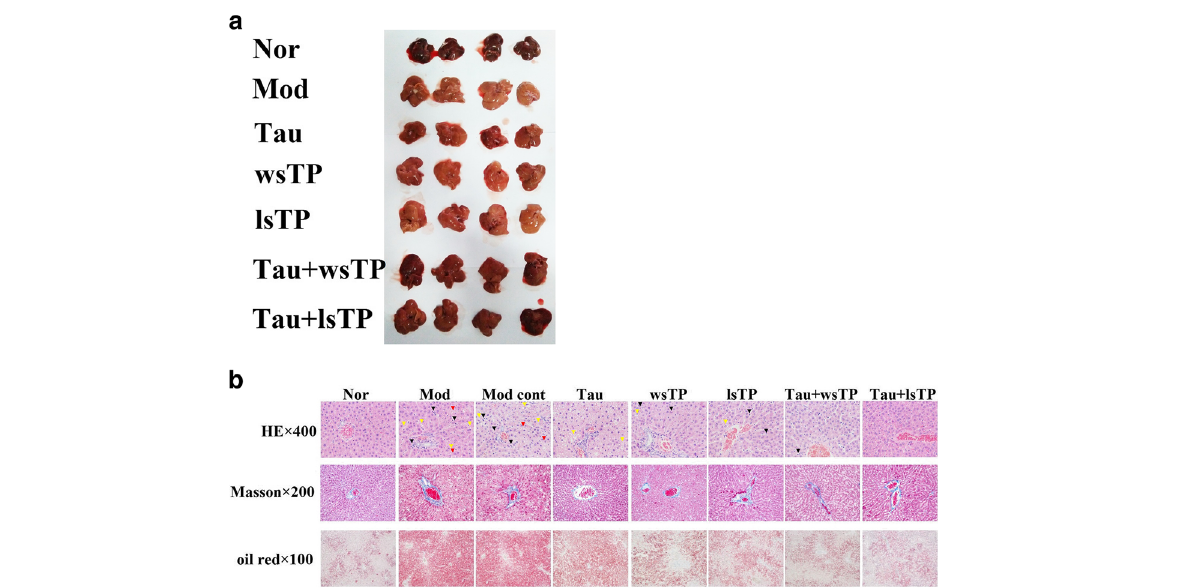
Fig. 4 Effect of taurine and/or TPs on histopathological changes in NASH rats. Gross pathological observation showed ruddy liver in the normal group, and yellow hepatomegaly in the model group and model control group. When treated NASH rats with taurine, wsTP, lsTP, taurine + wsTP, or taurine + lsTP, color of liver turned red more or less. When compared with taurine treatment group, wsTP treatment group or lsTP treatment group, respectively, the color of liver in the combination treatment groups (taurine + wsTP and taurine + lsTP) appeared redder ( a ). In the taurine treatment group, liver histological examinations showed normal liver or mild microvesicular steatosis without inflammatory infiltration or fibrosis in the normal group. Severe macro- and microvesicular steatosis (yellow arrow), infiltration of mild lobular mixed neutrophilic and mononuclear cells (black arrow), even focal necrosis, perisinusoidal and portal fibrosis, severe hepatocellular ballooning (red arrow) were observed in the model group and model control group. There were remarkable histological improvements in steatosis and inflammation in taurine treatment group, wsTP treatment group, lsTP treatment group, taurine + wsTP combination treatment group and taurine + lsTP combination treatment groups ( P < 0.05), compared with model group or model control group. In addition, the histological improvements in combination treatment group were more remarkable than in taurine group, wsTP group and lsTP group, respectively ( p < 0.05) ( b ). NASH, nonalcoholic steatohepatitis; Nor, normal group; Mod, model group; Mod cont, model control group; Tau, taurine treatment group; wsTP, water soluble tea polyphenols treatment group; lsTP, lipid soluble tea polyphenols treatment group; Tau + wsTP, taurine and water soluble tea polyphenols treatment group; Tau + lsTP, taurine and lipid soluble tea polyphenols treatment group; HE, hematoxylin and eosin staining